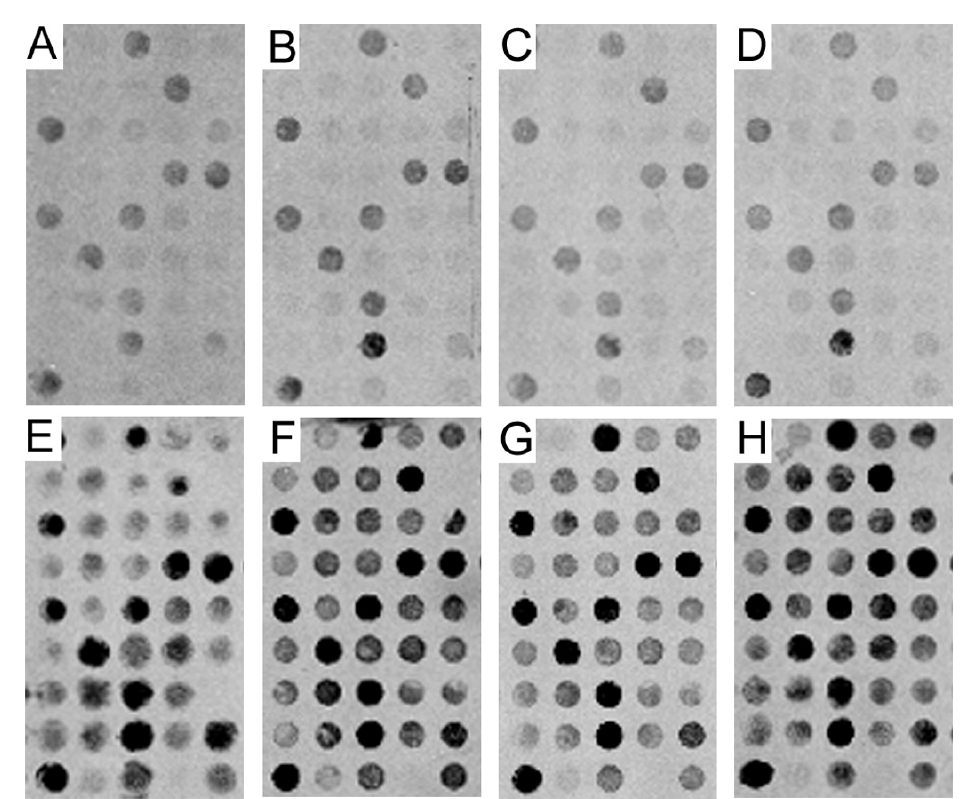
Figure 3 . Custom-designed cDNA array analysis utilizing aRNA (A-D) and TC RNA amplification without dialysis